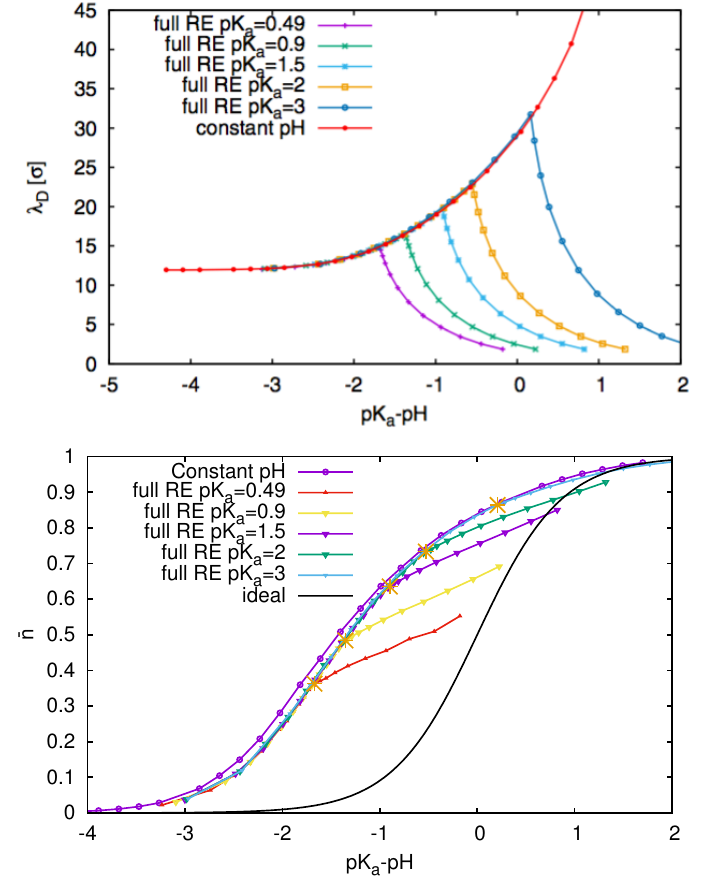
Figure 5. Resulting Debye-Hückel lengths λ D and degree of association ¯ n ( bottom ) for flexible weak polyelectrolytes with different pK a values and a fixed Bjerrum length as obtained by the reaction ensemble (RE) method and the constant pH method. The actual pH value of the solution is defined by the relation pK a -pH. Figures reproduced from Ref.